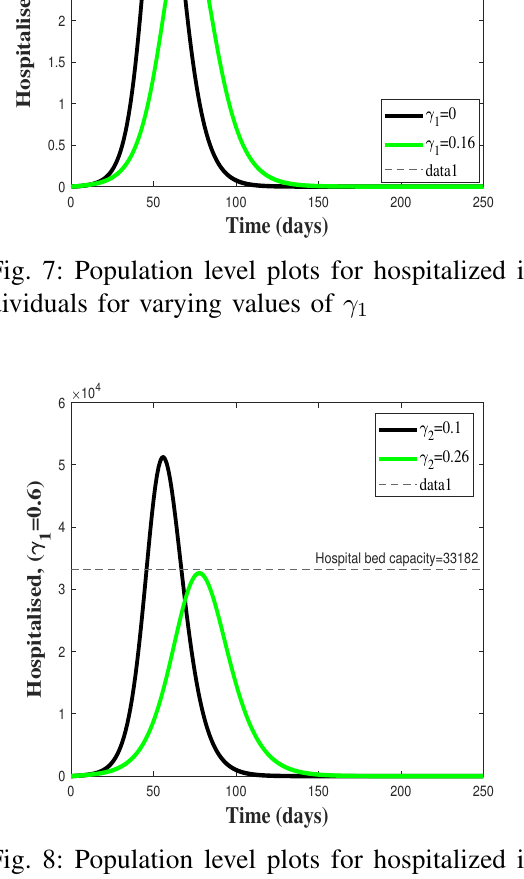
testing, contact tracing and isolating symptomatic infectives must be 2 . 3 times higher than that of isolating asymptomatic